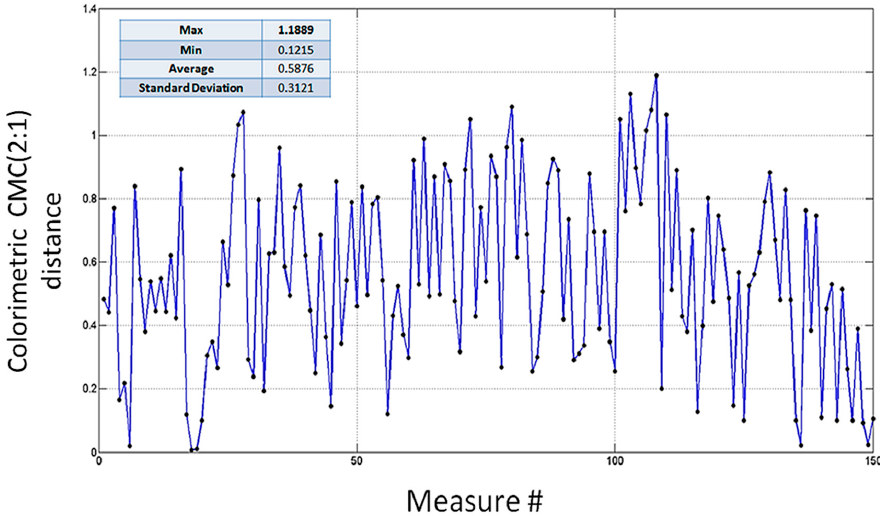
Figure 11. Distances DE((cid:1872)) (cid:3019) measured during the carding process.